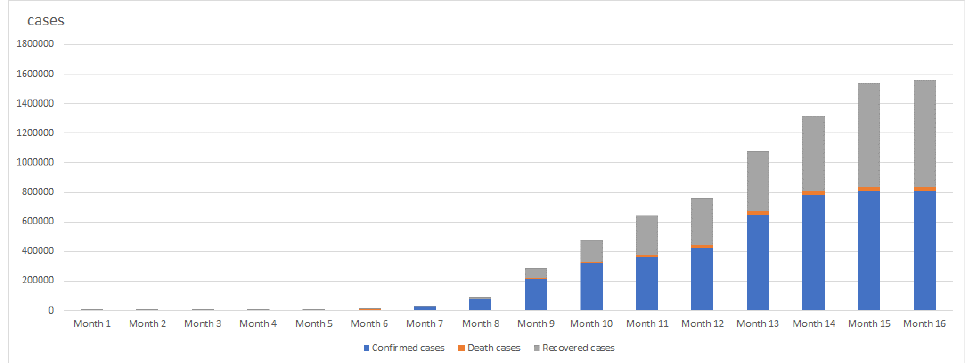
Figure 3: Total number of confirmed COVID-19 cases, deaths and recovered patients in